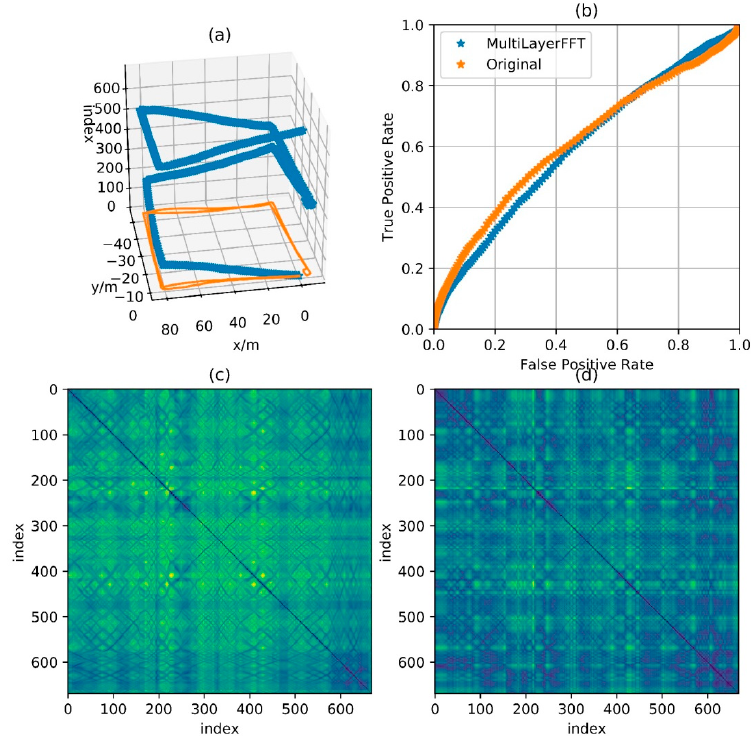
Figure 14. Comparison of performance between BDD and MFD in Path D. ( a ) Reference trajectory. ( b ) ROC of BDD and MFD. ( c ) Distance matrix of BDD. ( d ) Distance matrix of MFD.